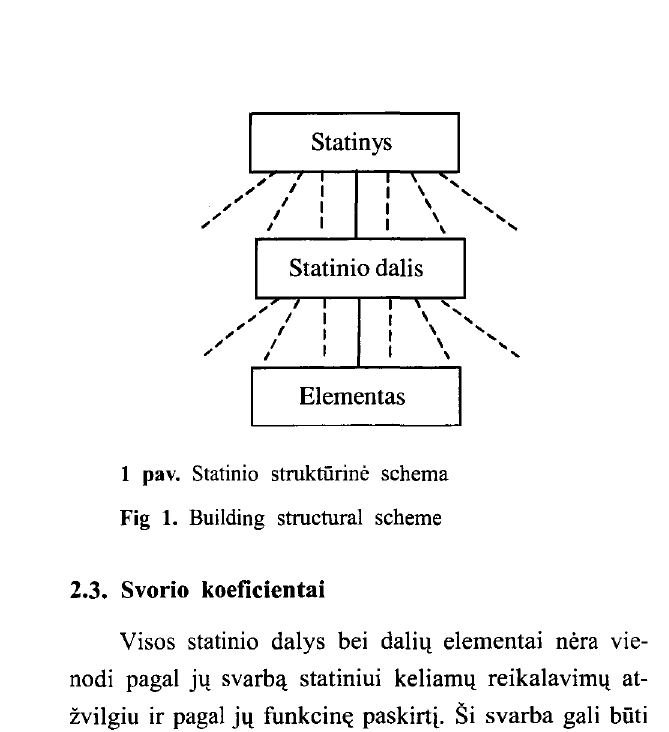
Fig 1. Building structural scheme